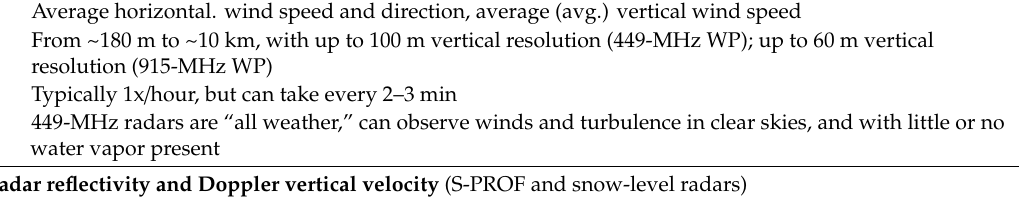
Table 1. Instruments and parameters measured at HMT–West network sites. ARO stations include a 449-MHz or 915-MHz WP radar and all the instrumentation below. Other sites shown in Figure 1 have one or more of the instruments described